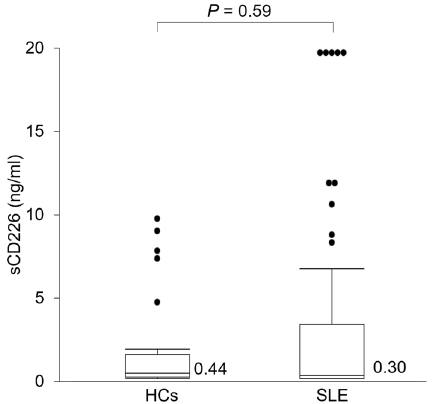
Figure 1. Serum sCD226 levels in SLE patients and HCs. Serum sCD226 levels were compared between SLE patients and HCs. Data are shown as box plots. The boxes represent the upper and lower IQRs; lines inside the boxes represent the median; whiskers represent 1.5 times the upper and lower IQRs; points outside the whiskers represent outliers. Statistical differences among groups were evaluated using the Mann–Whitney U test. sCD226